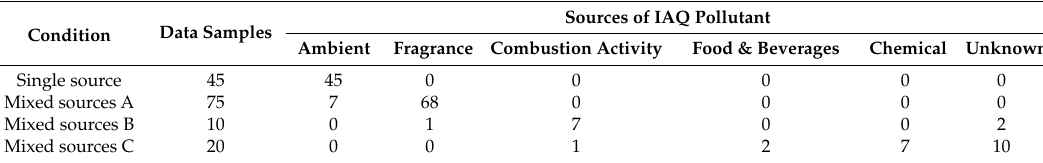
Figure 11. Sensor’s response when additional sources of IAP are present. Table 12. Result of the classifier based on mixed sources.